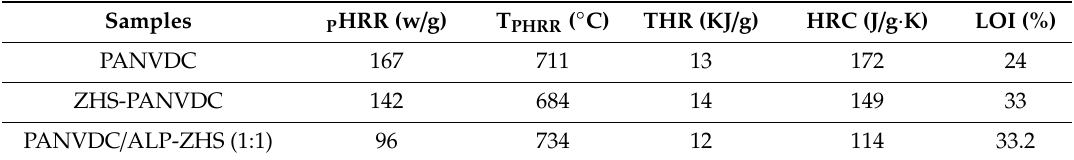
Table 4. Results of MCC and LOI tests of pure PANVDC, ZHS-PANVDC, and PANVDC /